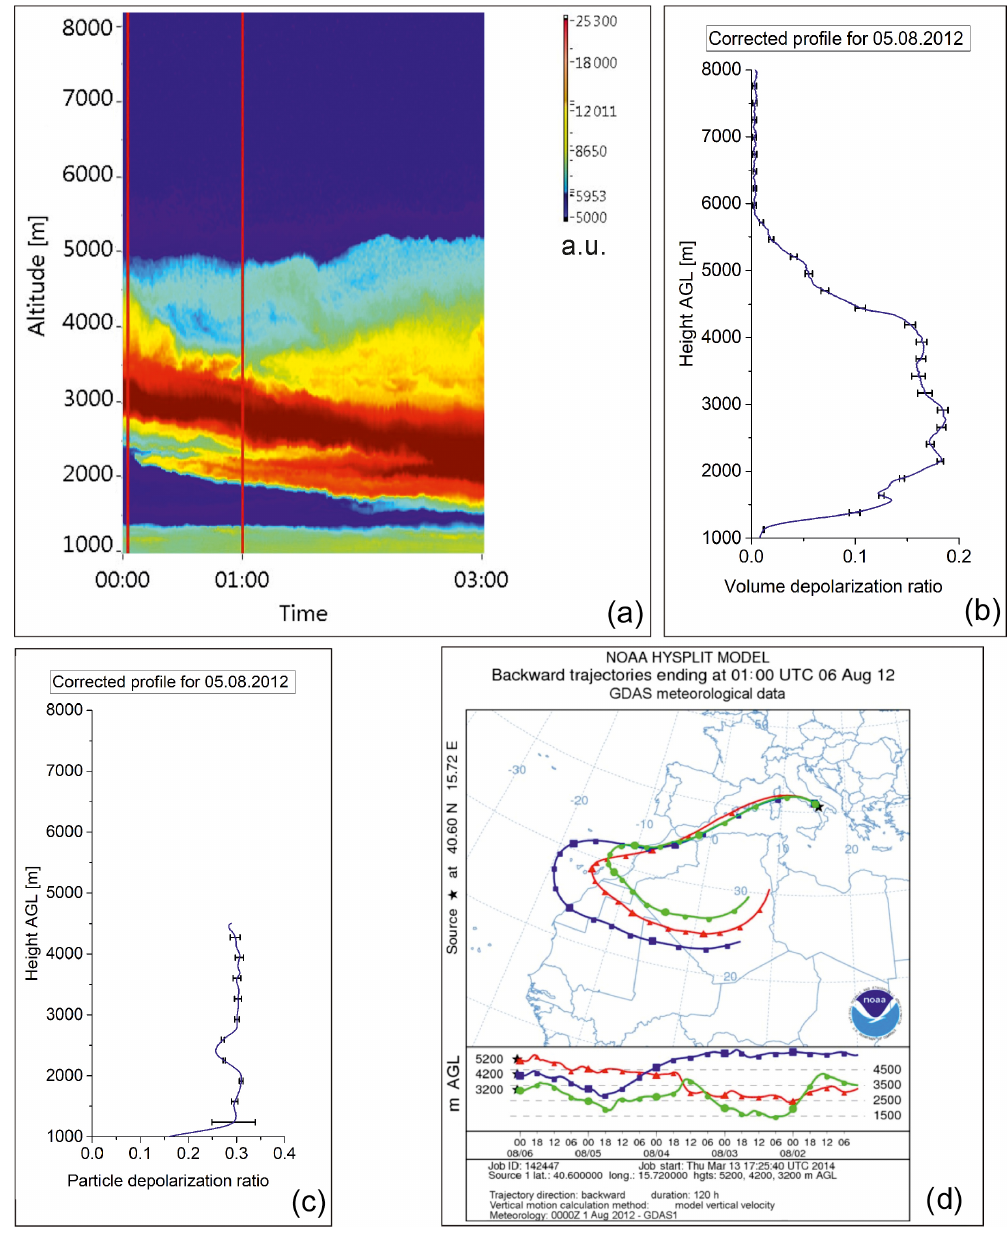
Figure 10. Data from 5 August 2012, at the MUSA-Potenza lidar system (a) range-corrected time series at 532nm; (b) volume linear depolarization ratio is a corrected profile at 532nm – smoothed data, 1h average, 45m vertical smoothing; (c) particle linear depolarization ratio is a corrected profile at 532nm – smoothed data, 1h average, 45m vertical smoothing; (d) HYSPLIT back-trajectory analysis ( − 120h) for the detected layers, at the Potenza